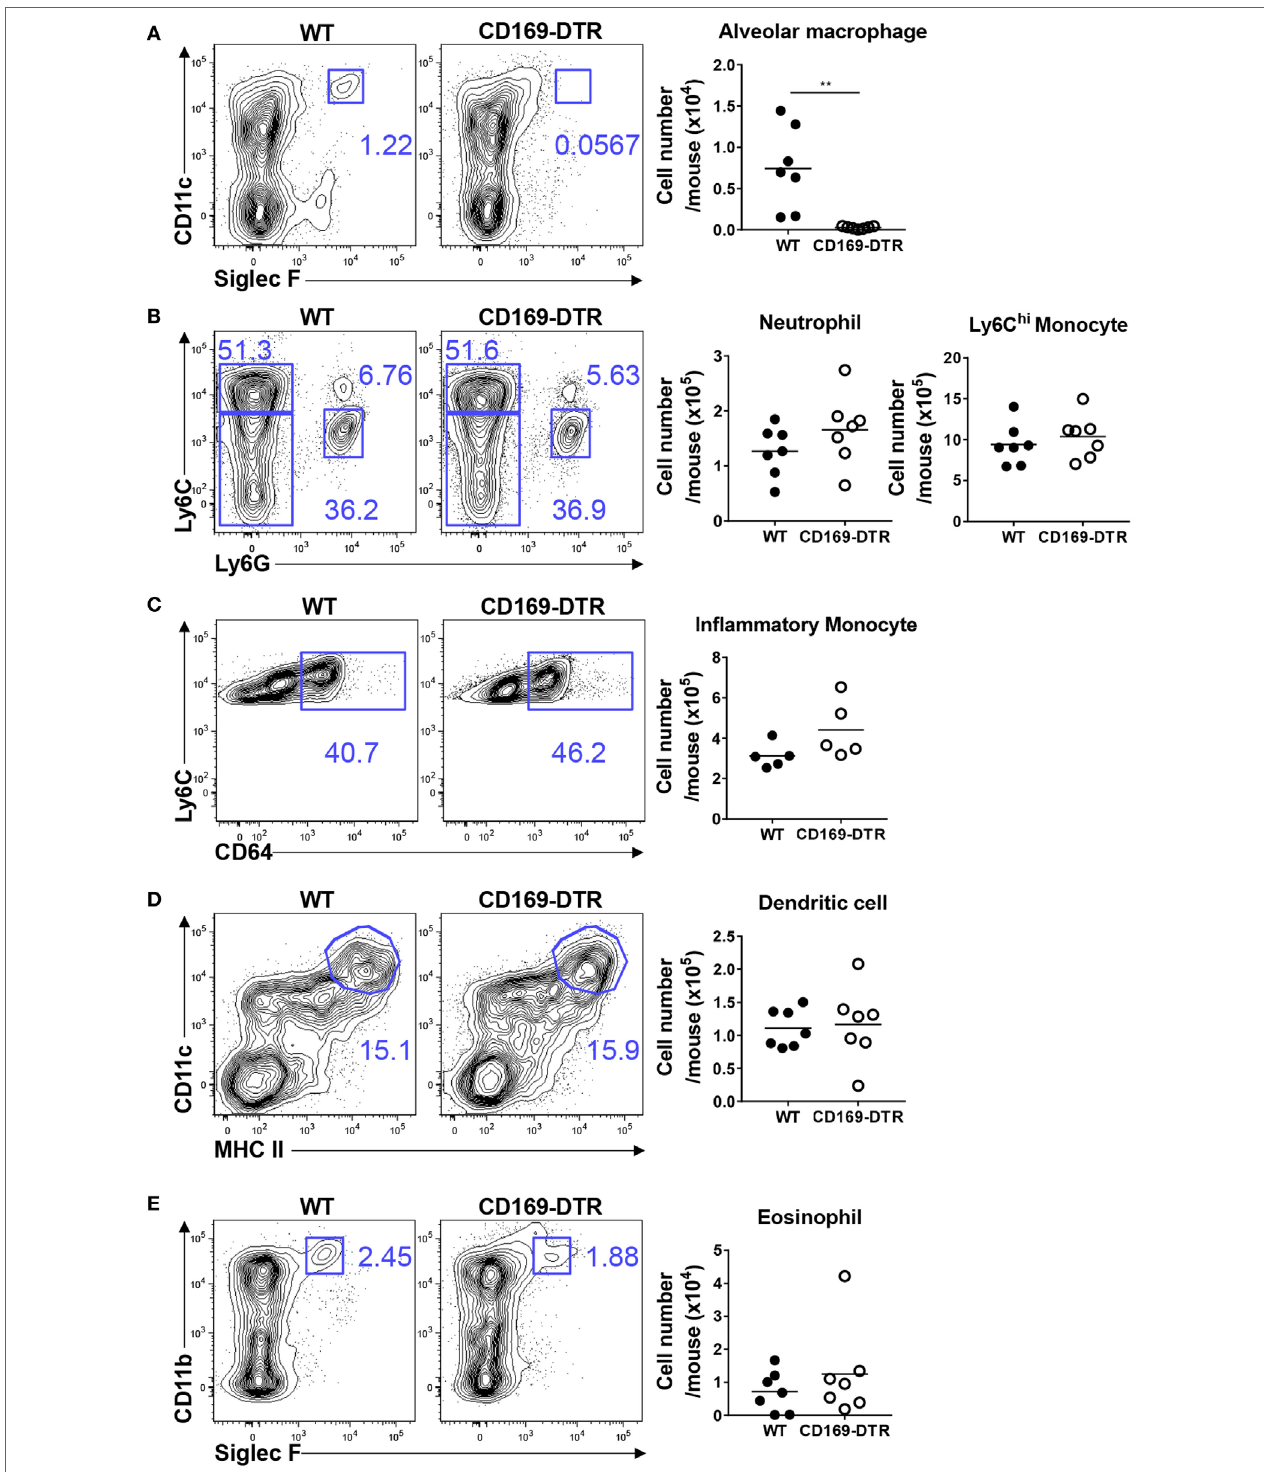
FigUre 4 | CD169 + cell depletion does not affect the lung recruitment of inflammatory cells 5 days after respiratory syncytial virus (RSV) infection. Five days after RSV infection, the lungs of diphtheria toxin-treated wild-type (WT) and CD169-diphtheria toxin receptor (DTR) mice were collected, processed, and analyzed by flow cytometry. The numbers of alveolar macrophages (a) , monocytes and neutrophils (B) , inflammatory monocytes (c) , dendritic cells (D) , and eosinophils (e) indicate the frequencies in gated cells. Cell number results are shown in the graphs. Each dot represents an individual mouse ( n = 7 in each group). Statistically significant differences between groups are indicated: ** P < 0.01. Data are representative of two independent experiments.